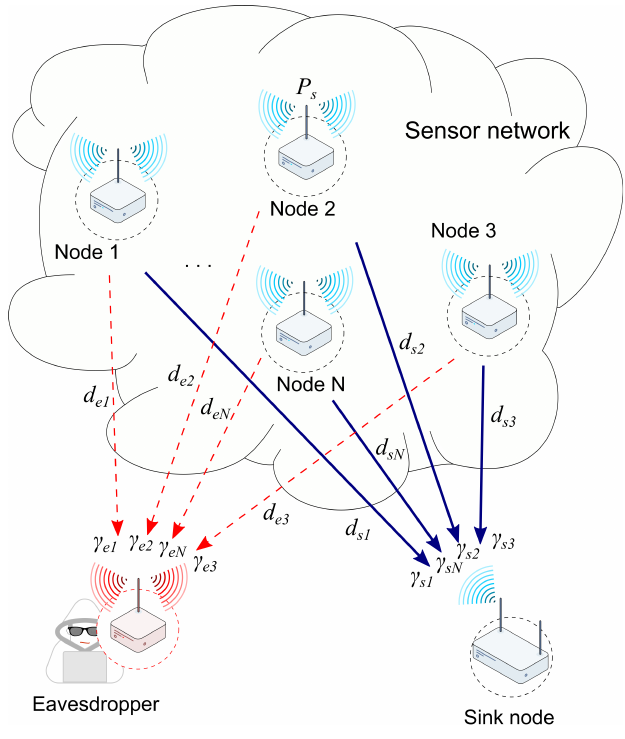
Figure 1. System model